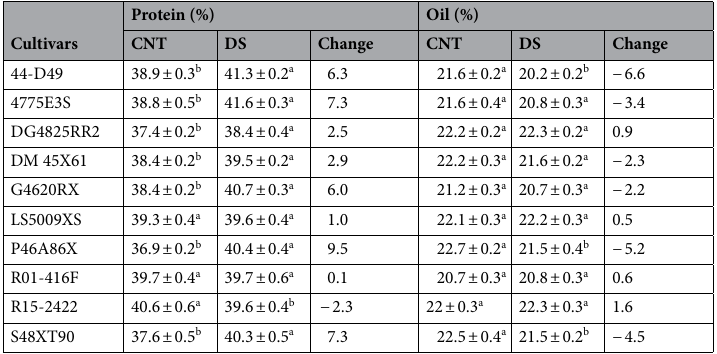
Table 2. Variation in seed protein and oil content of ten soybean cultivars grown under control and drought stress. Values represent mean ( n = 10) ± SE for the quality parameters of the ten soybean cultivars under control (CNT) and drought stress (DS). Different letters in superscript indicate the significant treatment effect for a given parameter between treatments. Negative value represents a percentage reduction and positive value represents a percentage increase under drought stress compared to